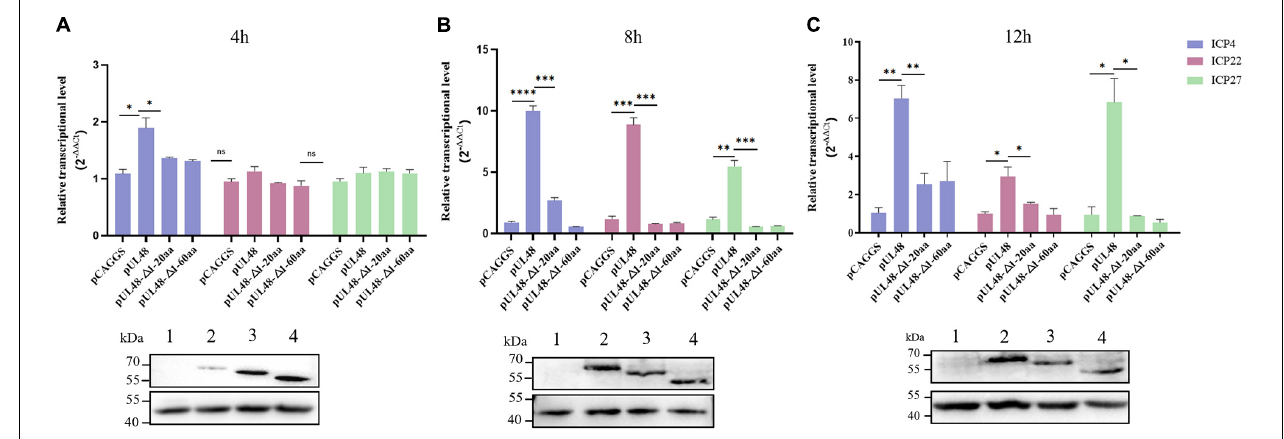
FIGURE 6 | Effect of overexpression of pUL48 and its truncated protein on viral IE gene transcription. The relative transcription level of the IE gene at 4/8/12 h after infection with MOI = 1 DPV-CHv; pCAGGS, pCAGGS-pUL48-HA, pCAGGS-pUL48 ( (cid:49) 1–20 aa)-HA, and pCAGGS-pUL48 ( (cid:49) 1–60 aa)-HA were transfected into a 12-well plate DEF, respectively. At 12 h after transfection, DEF was infected with DPV CHv strain with MOI = 1. The virally infected cells were collected 4, 8, and 12 h after infection into the non-RNA enzyme EP tube using RNAiso Plus. According to the instructions of the RNA extraction kit, reverse transcription reagent and SYBR R (cid:13) Premix Ex Taq TM II Kit, RNA extraction, reverse transcription, and quantitative fluorescence PCR were performed successively to detect the mRNA levels of IE gene ICP4, ICP22, and ICP27. The expression of each truncated protein of pUL48 was detected by WB. 1, pCAGGS; 2, pUL48; 3, pUL48 ( (cid:49) 1–20 aa); 4: pUL48 ( (cid:49) 1–60 aa). Relative quantitative test results were processed using 2 - (cid:49)(cid:49) Ct, and the results were normalized to the control group. Student’s t -test was used to analyze the experimental and control groups differences. ∗ p < 0.05, ∗∗ p < 0.01, ∗∗∗ p < 0.001, ∗∗∗∗ p < 0.0001.